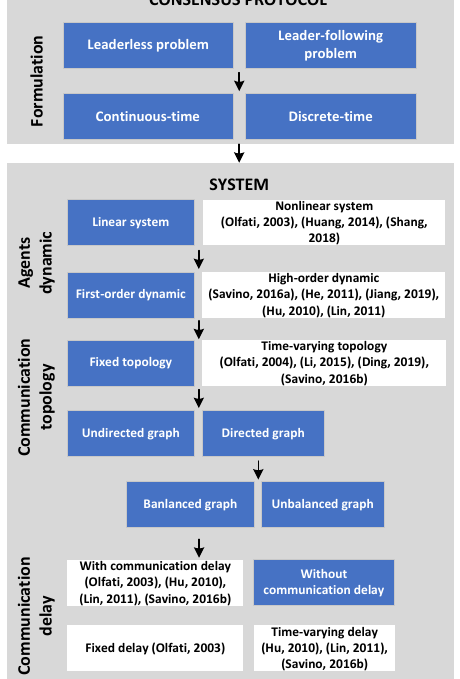
Figure 3. Overview of the main variations of consensus protocol formulation according to the agents, system topology and objectives. The white blocks grouped the applications of consensus into more complex systems.: Legend: Olfati, 2004 [21], Olfati, 2003 [22], Huang, 2014 [23], Shang, 2018 [24], Savino, 2016a [25], He, 2011 [26], Jiang, 2019 [27], Hu, 2010 [28], Lin, 2011 [29], Li, 2015 [30], Ding, 2019 [31], Savino, 2016b